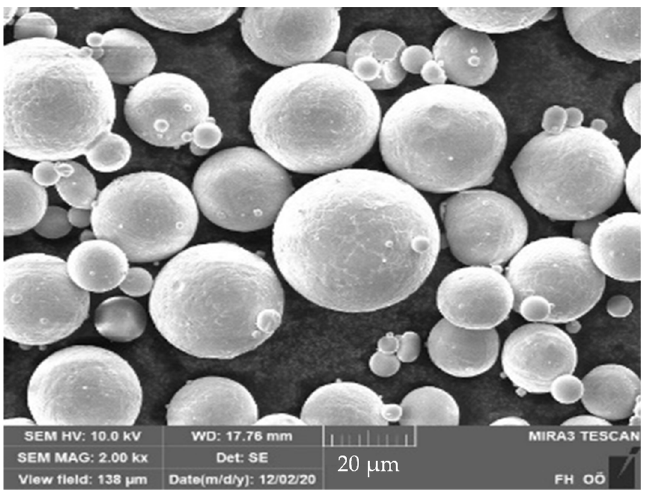
Figure 2. SEM photograph of the morphology of the AISI H10 hot-work tool steel powder particles.